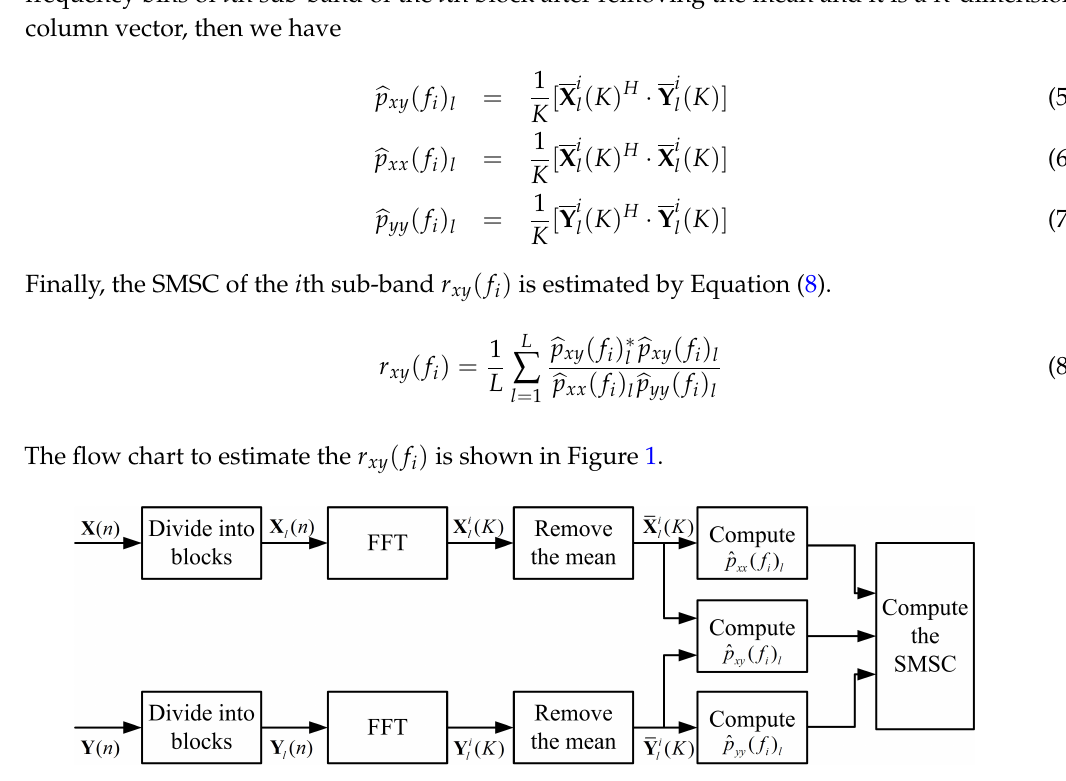
Figure 1. The flow chart to estimate the sub-band magnitude-squared coherence